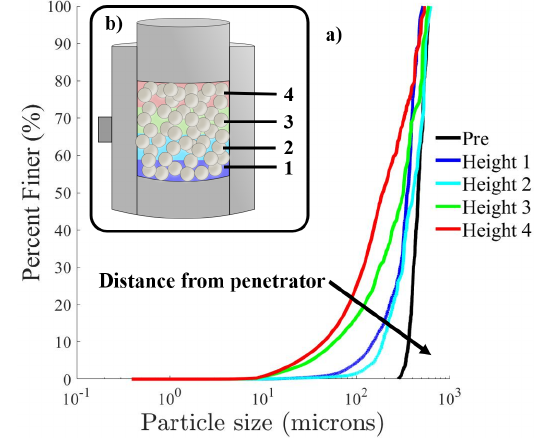
Figure 4. (a) PSD post-impact at di ff erent heights inside die, (b) illustration of varying heights within